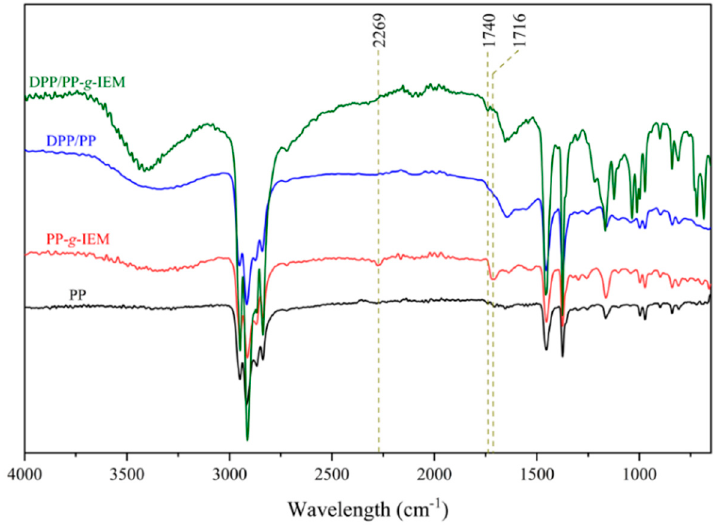
Figure 5. FTIR spectra of PP, PP- g -IEM, DPP-T/PP, and DPP-T/PP- g -IEM. The FTIR spectrum of the (DPP-T)- g -TsCl/PP- g -AcAM bio-composite (Figure 6) reveals a peak at 1741 cm − 1 , which can be traced to the stretching frequency of the C=O group from AcAm. This peak validated the formation of amide linkages because of the reaction between -TsCl and -NH 2 on the filler and polymer surfaces, respectively.